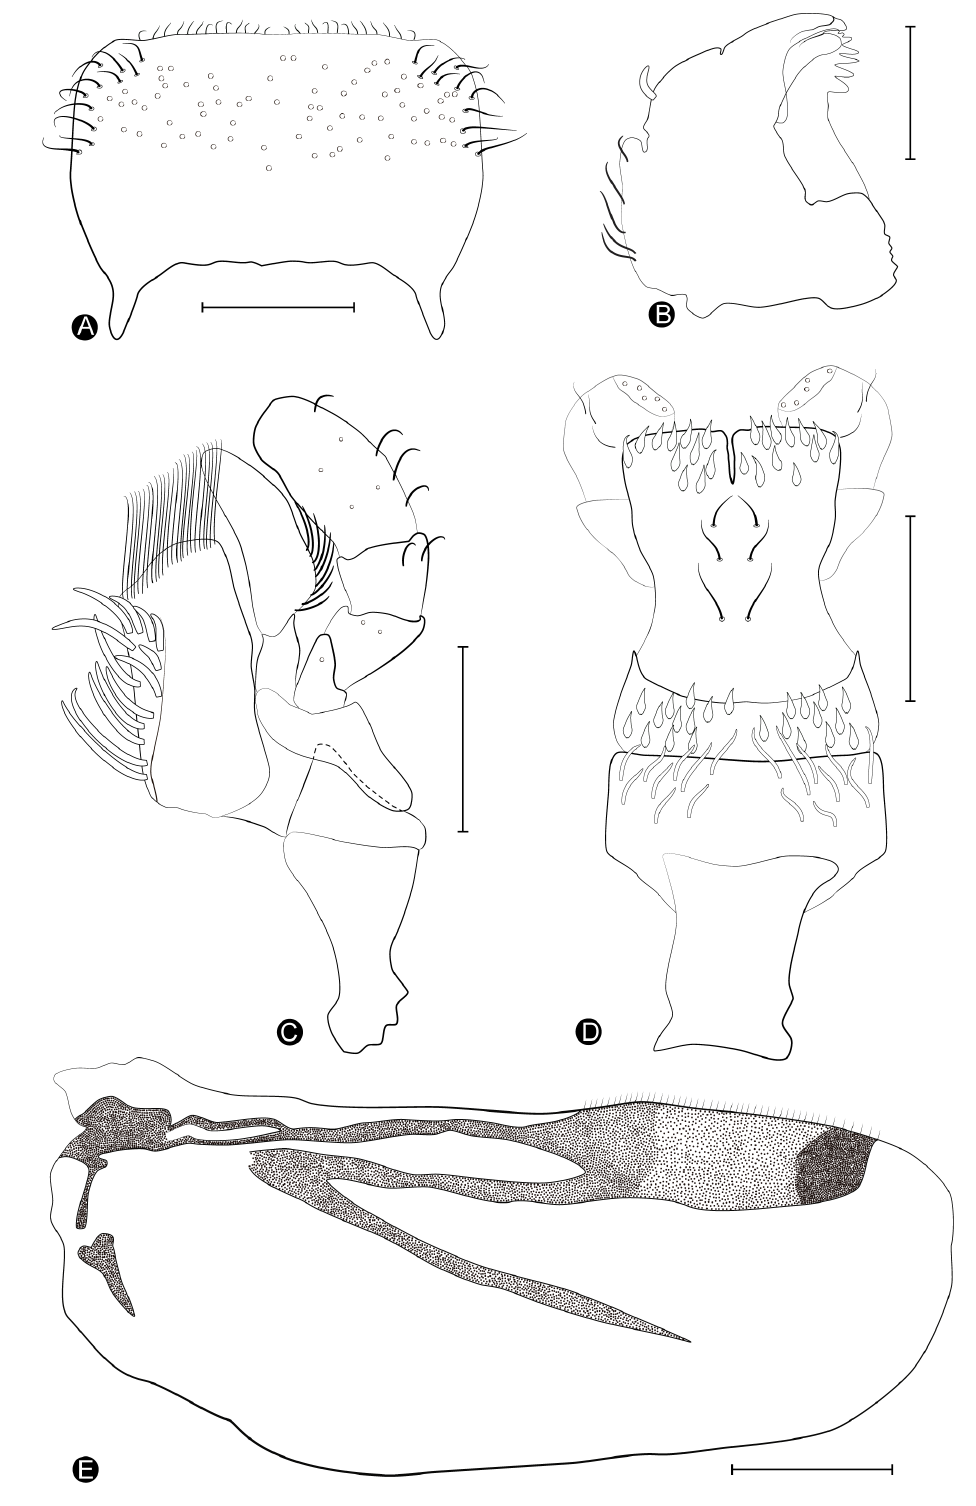
Fig. 3. Spanglerelmis xiririca Polizei & Bispo gen. et sp. nov. (MZSP31453). Dorsal view. A – D . Mouthparts. A . Labrum (setae are represented by punctures). B . Left mandible. C . Right maxilla. D . Labium. E . Metathorax wing (micropterous). Scale bars = 0.1